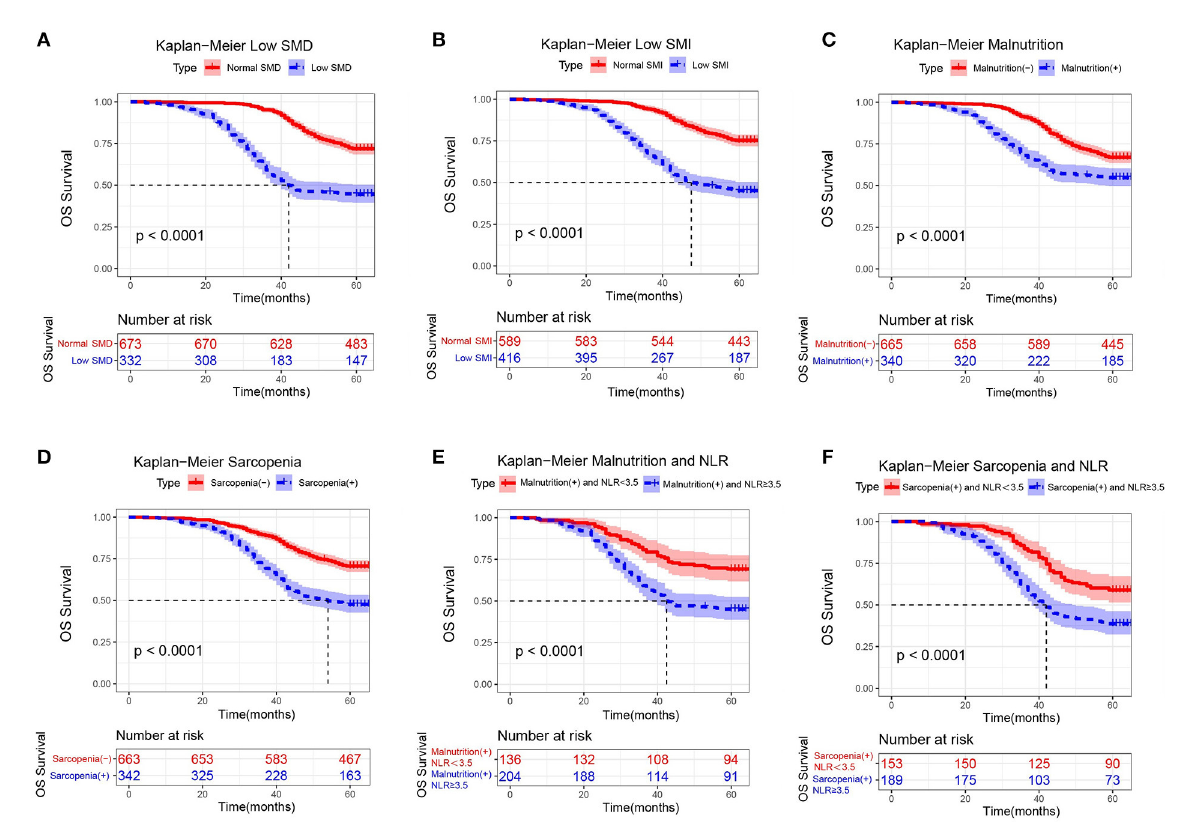
FIGURE6 Kaplan-Meier curves for overall survival, stratified by (A) low SMD, (B) low SMI, (C) malnutrition, (D) sarcopenia, (E) malnutrition and NLR, and (F) sarcopenia and NLR in the training cohorts ( n =